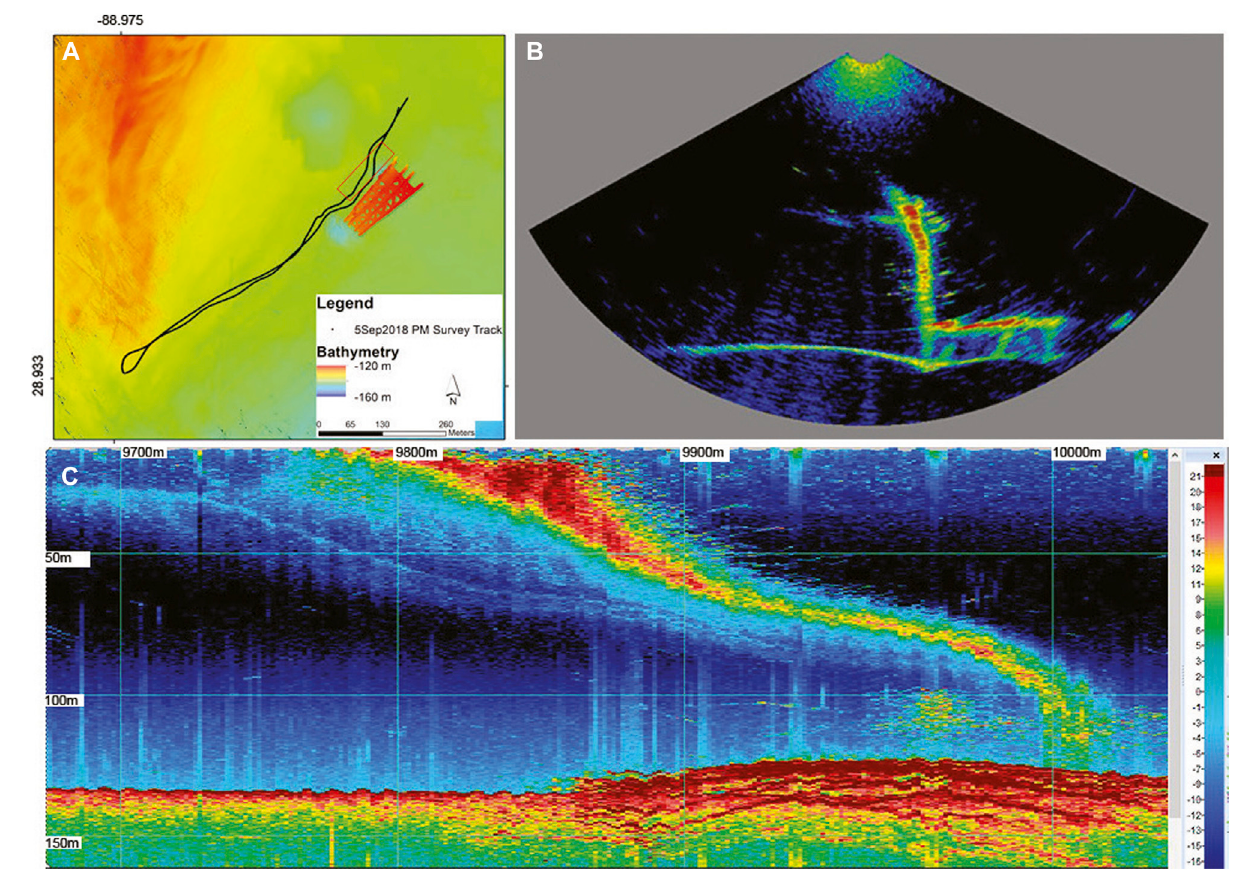
FIGURE5| Mapandsampleechogramsfromthesurveyconducted ontheeveningof5September. (Aupperleft) Mapoftheechosoundersurvey;bathymetryis represented by the colored ramp, and the red box represents the approximate area shown in the maximum intensity echogram. (B upper right) A single ping from the multibeam swath. (C lower) Multibeam echogram shown as maximum intensity across the beam swath and compressed along the track to show the trajectory and extent relative to the jacket. Two plume components are visible in the lower echogram, original Fig. 3.9 (Mason et al., 2019).